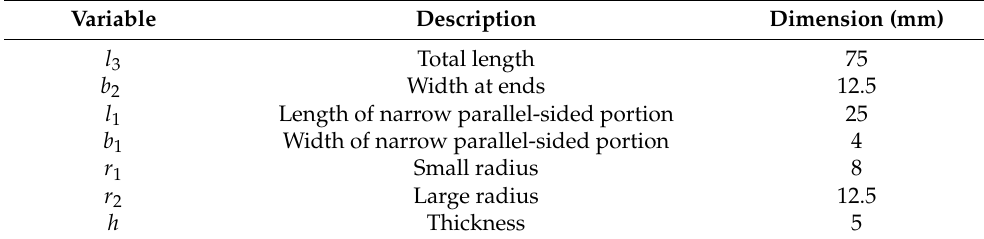
Table 3. Test specimen dimensions according to ISO 527-2 type 5A.